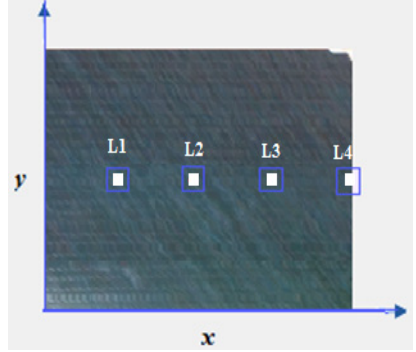
Figure 1. Location of the attached mass